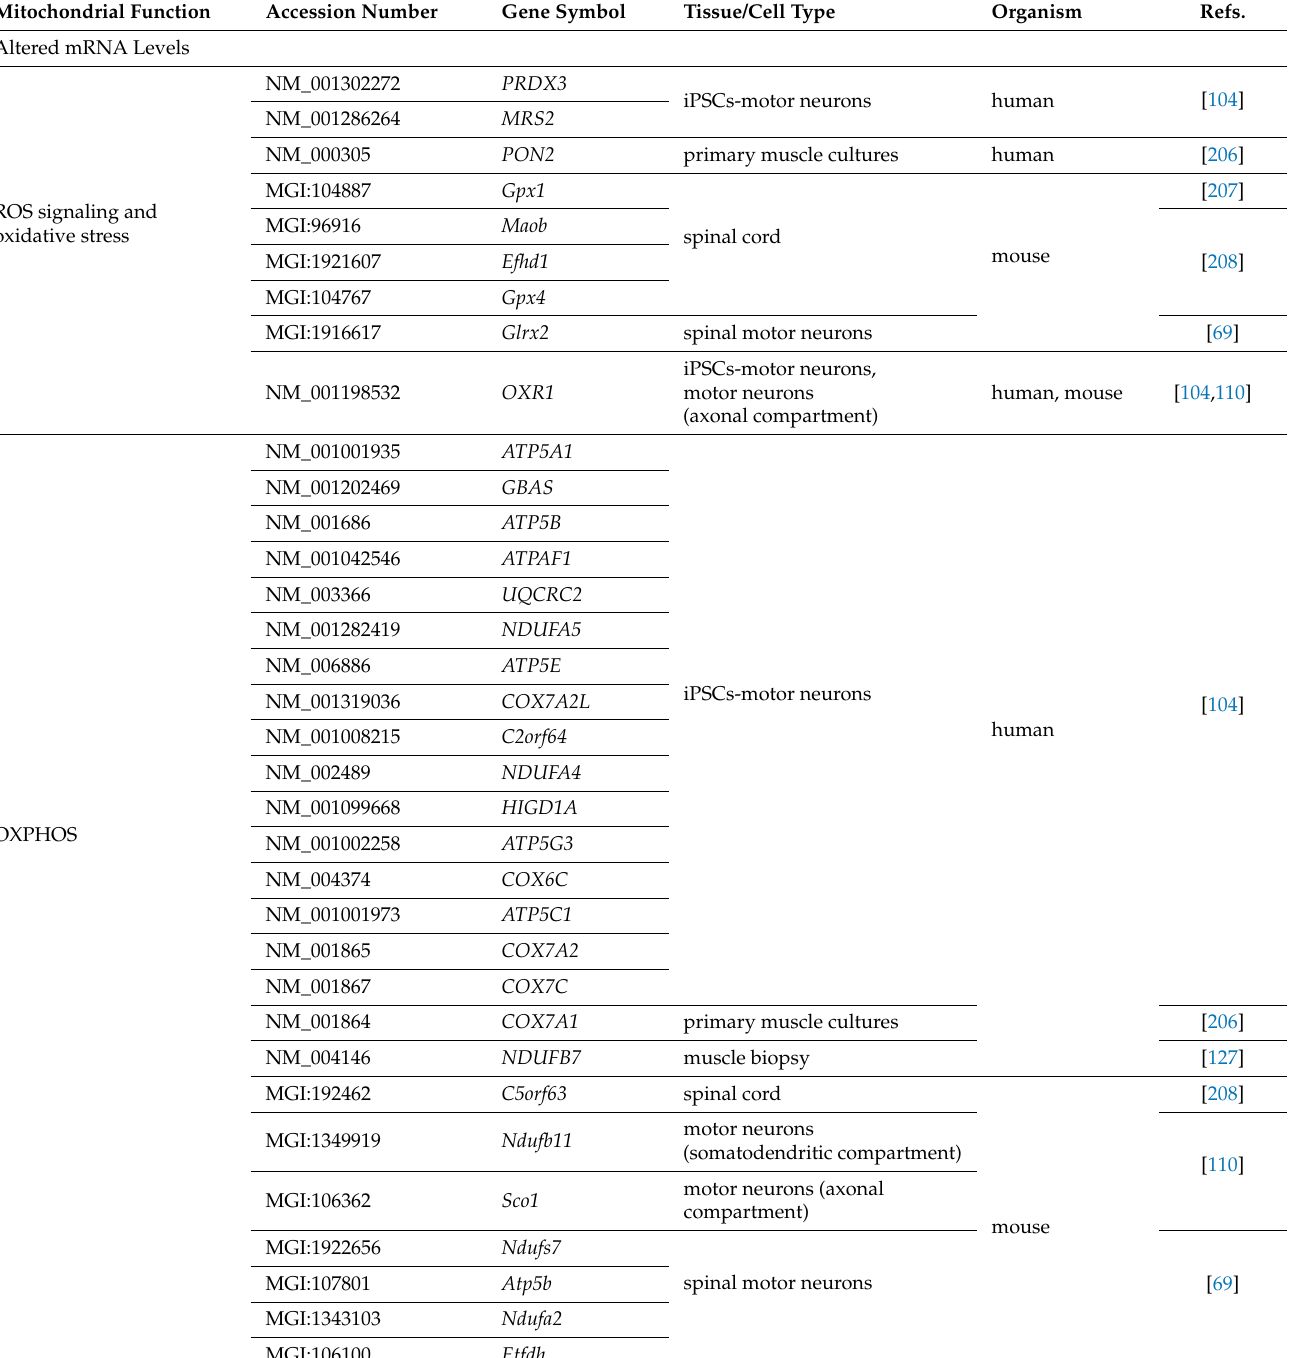
Table 1. mRNA of genes encoding mitochondria-associated proteins that are either altered upon SMN loss, associated to SMN, translated by SMN-primed ribosomes or potential SMA modifiers.